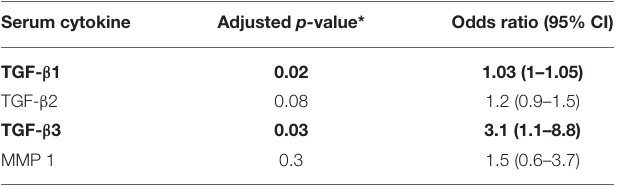
3 or MMP 9 with PHE or long-term functional